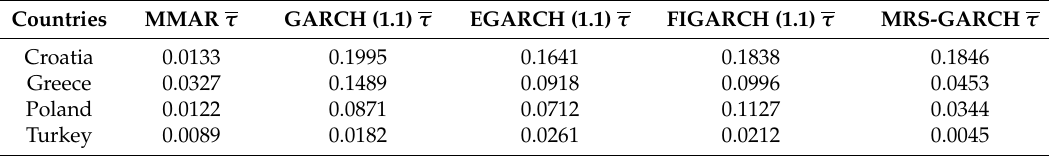
Table 11. Standard deviation of the scaling function values from ˆ τ empirical